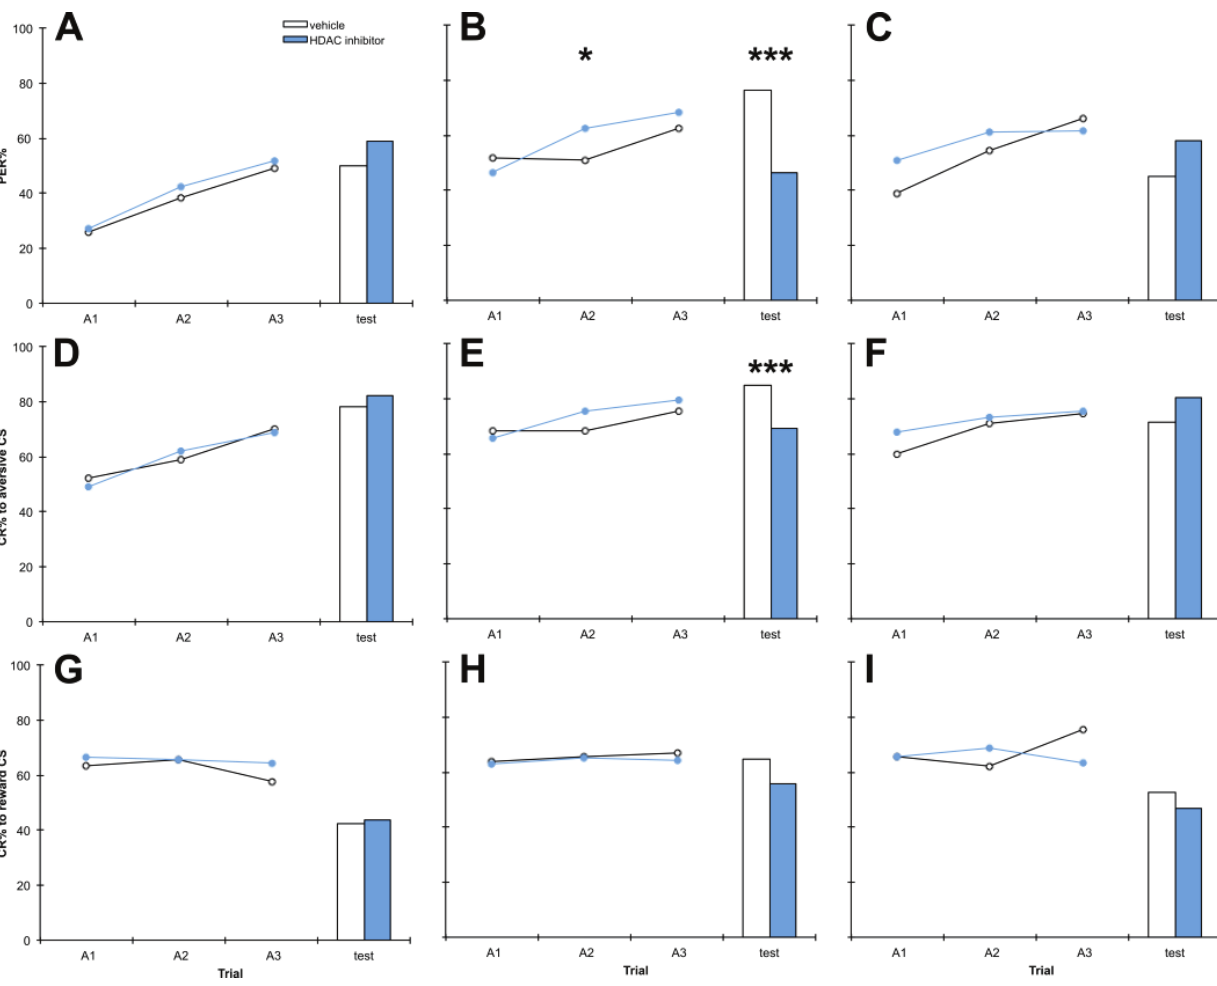
Figure 2. The HDAC inhibitor phenylbutyrate PB) impairs aversive memory at test at 10 mM but not 1 mM or 50 mM. Bees were treated with 1 mM ( A , D , G ), 10 mM ( B , E , H ) or 50 mM ( C , F , I ) C8 or vehicle only, 1 h after training. Panels A – C show discrimination learning and memory, panels D – F show aversive learning and memory and panels G – I show reward learning and memory, during acquisition training (A1,A2,A3) and at the retention test. 1 mM: n PB = 90, n vehicle = 90; 10 mM: n PB = 227, n vehicle =